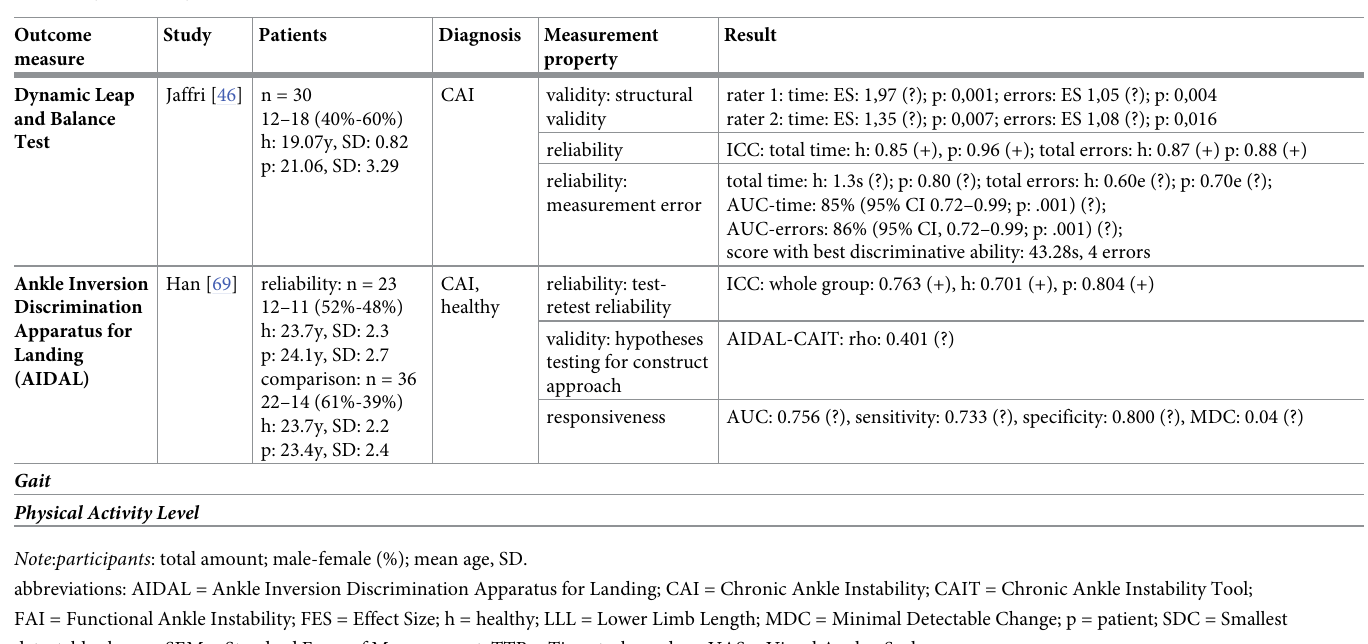
table adapted from COSMIN